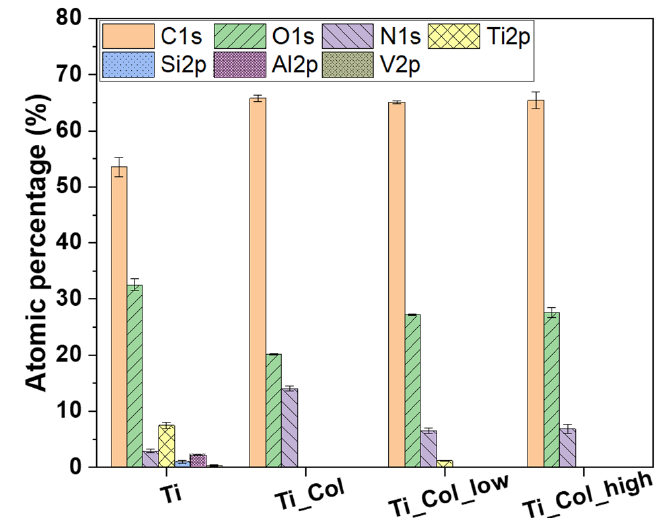
Figure 3. Atomic composition of uncoated and coated titanium samples. Error bars represent the standard error of the mean. Ti: titanium alloy Ti6Al4V; Ti_Col: collagen-coated Ti; Ti_Col_low: collagen and low PG concentration-coated Ti; Ti_Col_high: collagen and high PG concentration- coated